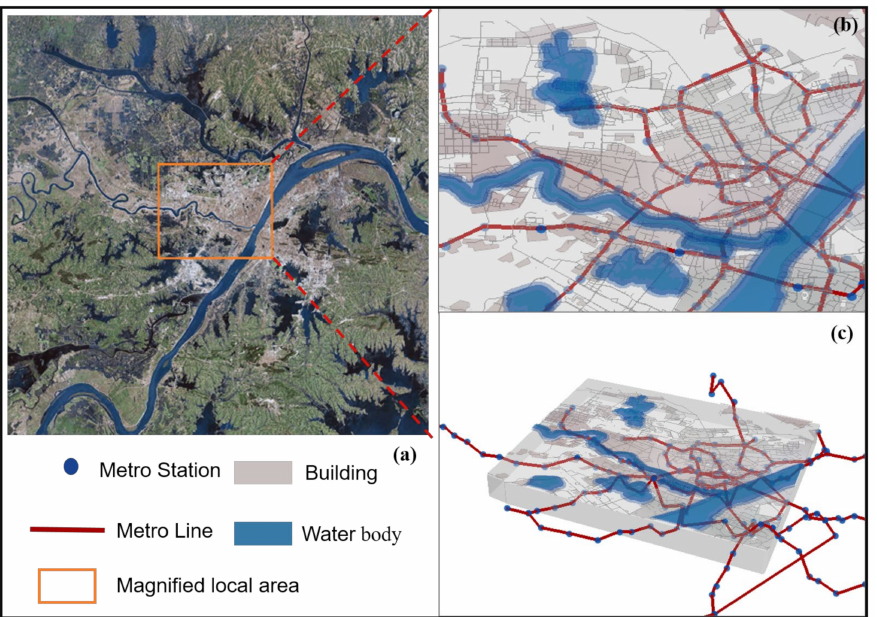
Figure 4. Urban metro diagram. ( a ) Remote sensing image of the Wuhan city. ( b ) Two-dimensional map of urban metro. ( c ) Three-dimensional map of urban